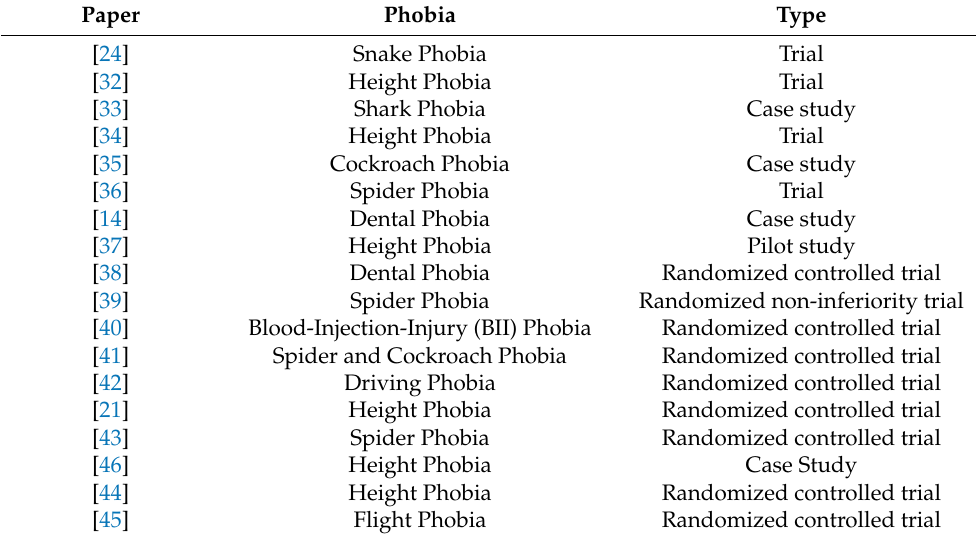
Table 3. Type of papers.